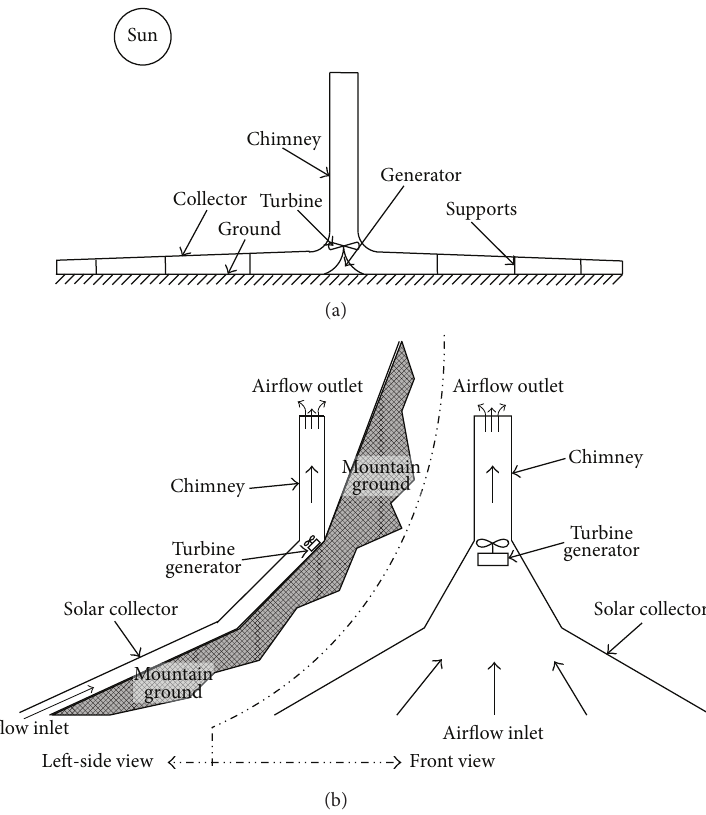
Figure 1: Schematic of the solar chimney power system: (a) on horizontal surface, (b) on sloped